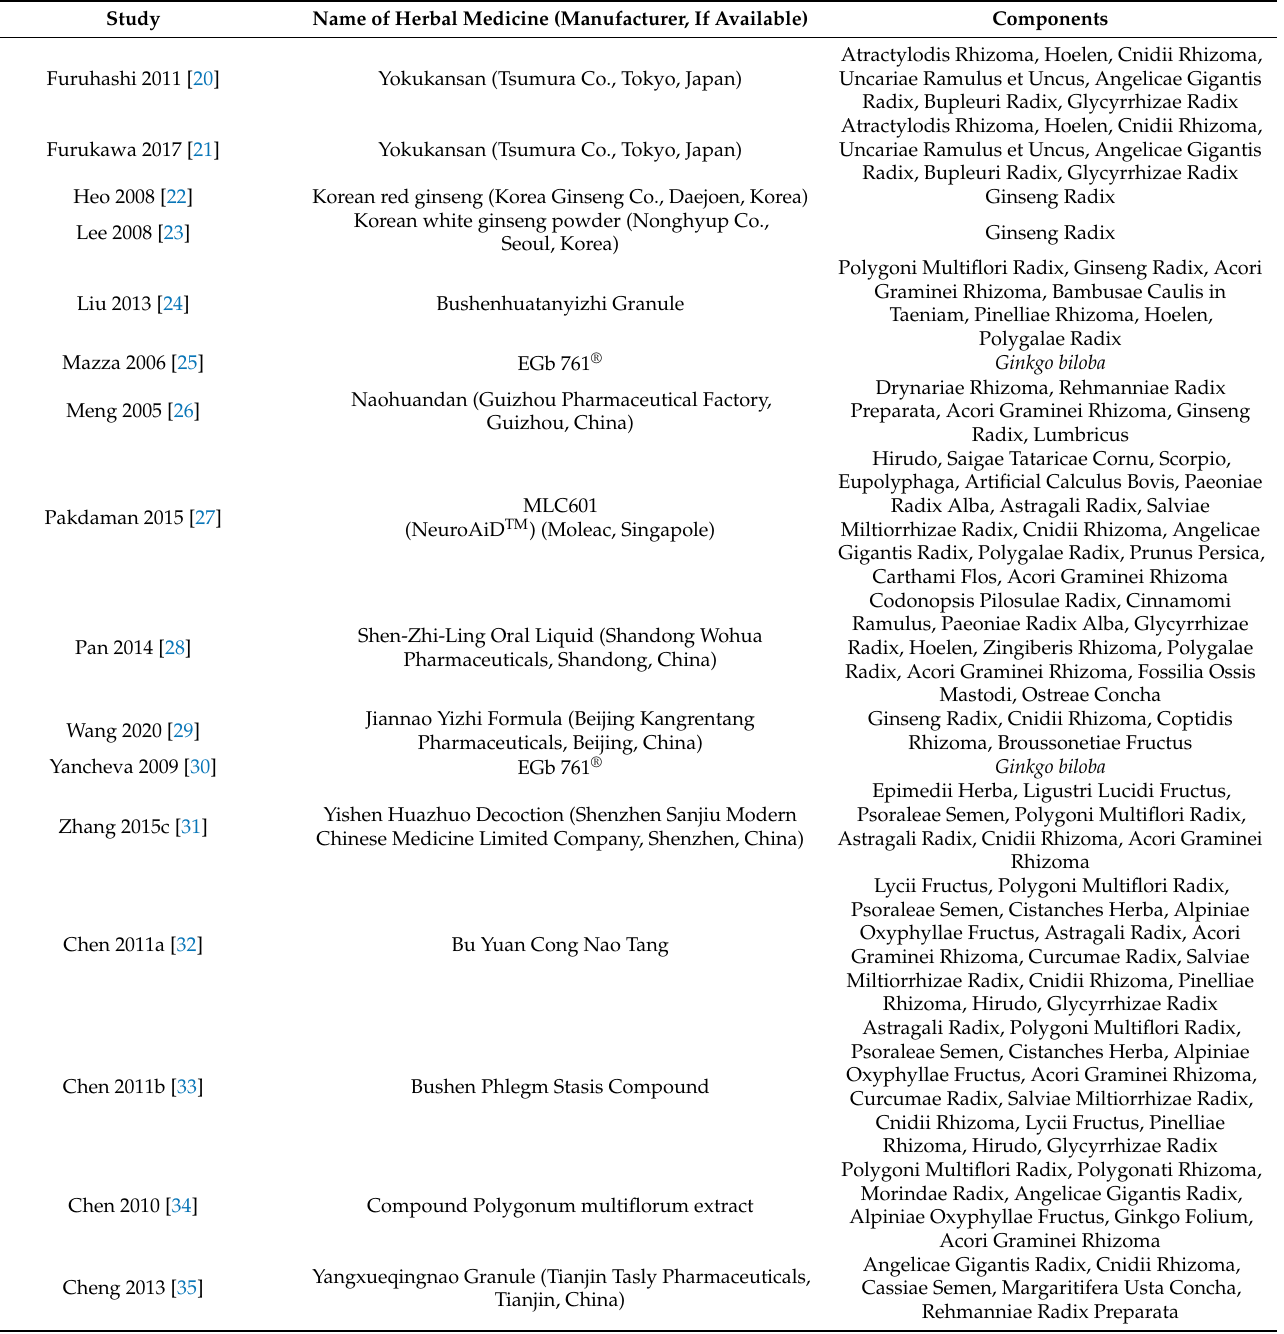
Table A1. Herbal Medicines Used in the Included